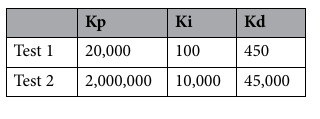
Table 2. PID parameters used in the test.